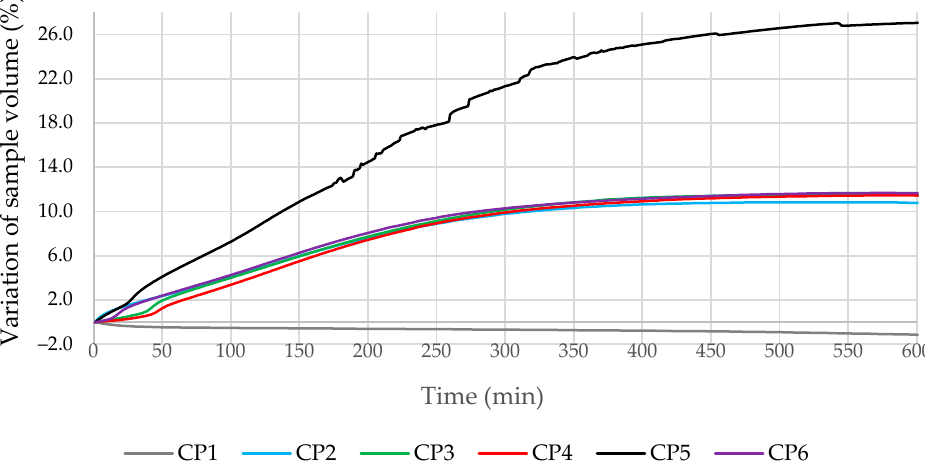
Figure 4. Test results for the changes in cement paste volumes due to hydrogen gas evolution.